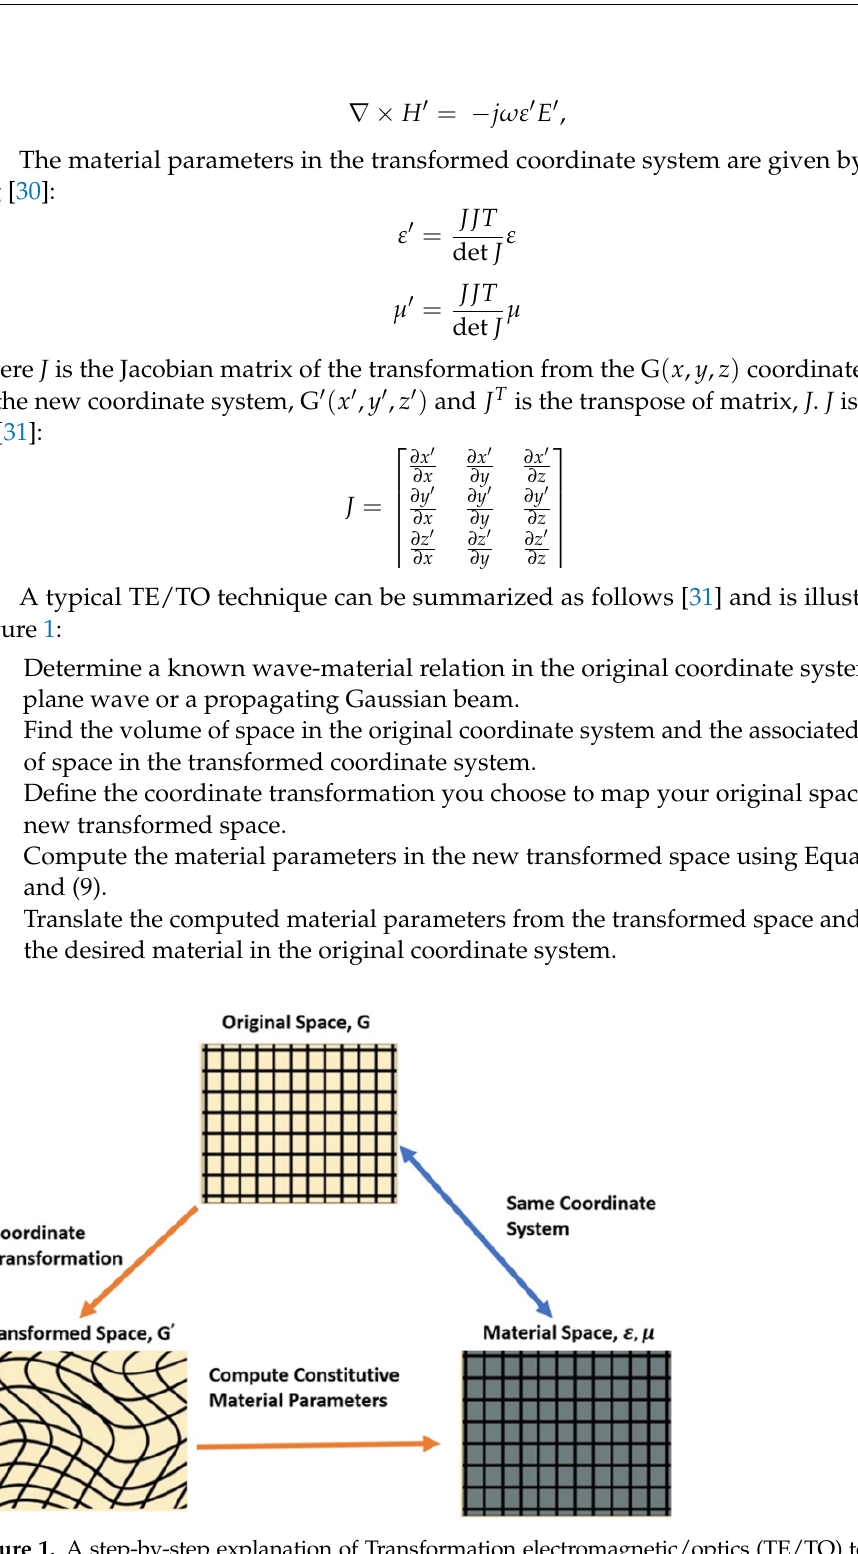
Figure 1. A step-by-step explanation of Transformation electromagnetic/optics (TE/TO) technique, where an original space, G is transformed into a new space, G (cid:48) , with new material parameters ε , µ